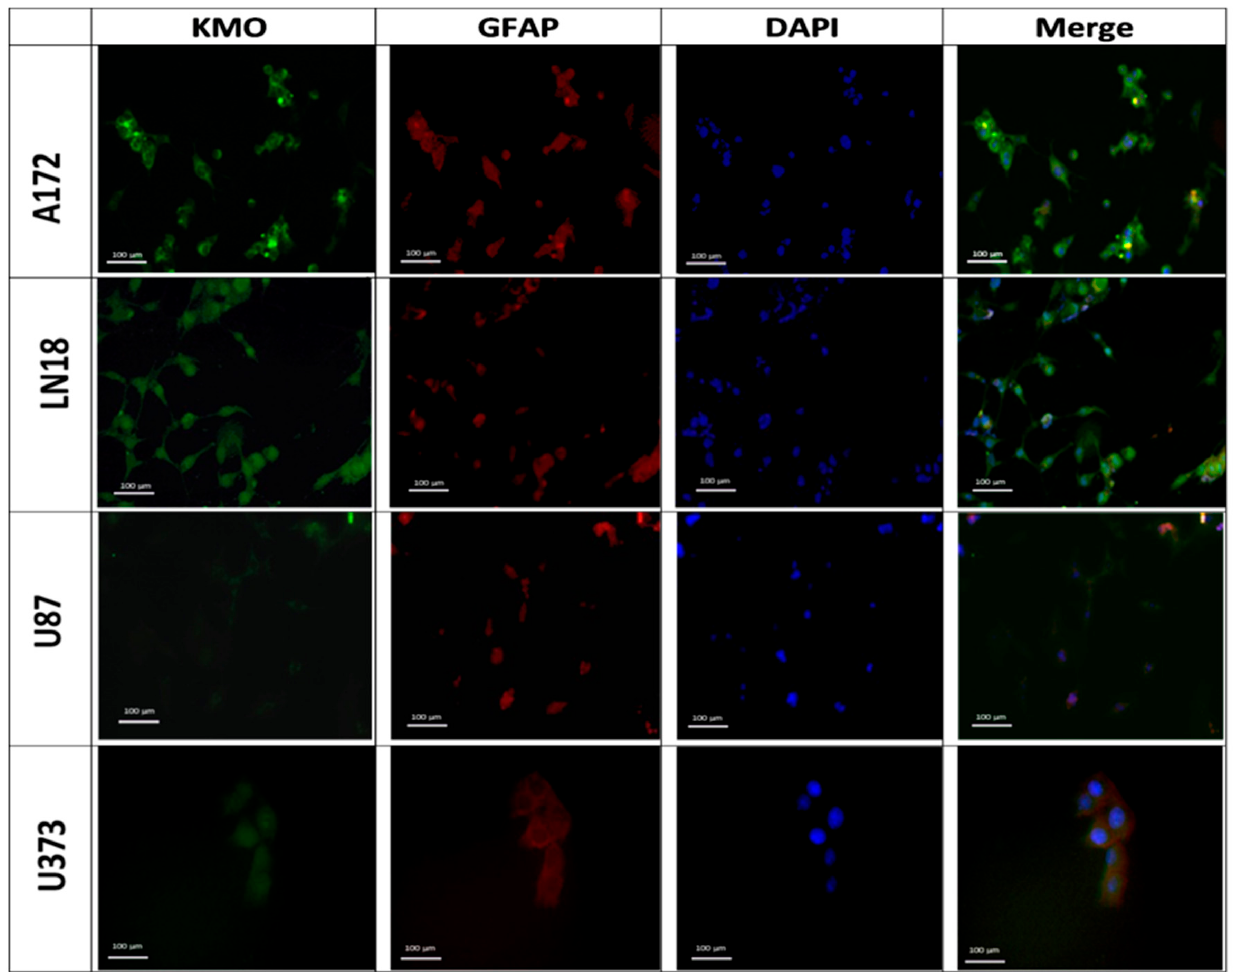
Figure 2. Kynurenine monooxygenase expression in GBM cell lines. Representative images of KMO protein expression in GBM cell lines A172, LN-18, U87, and U373. Images were acquired at 40× magnification. Scale bars represent 100 µm.